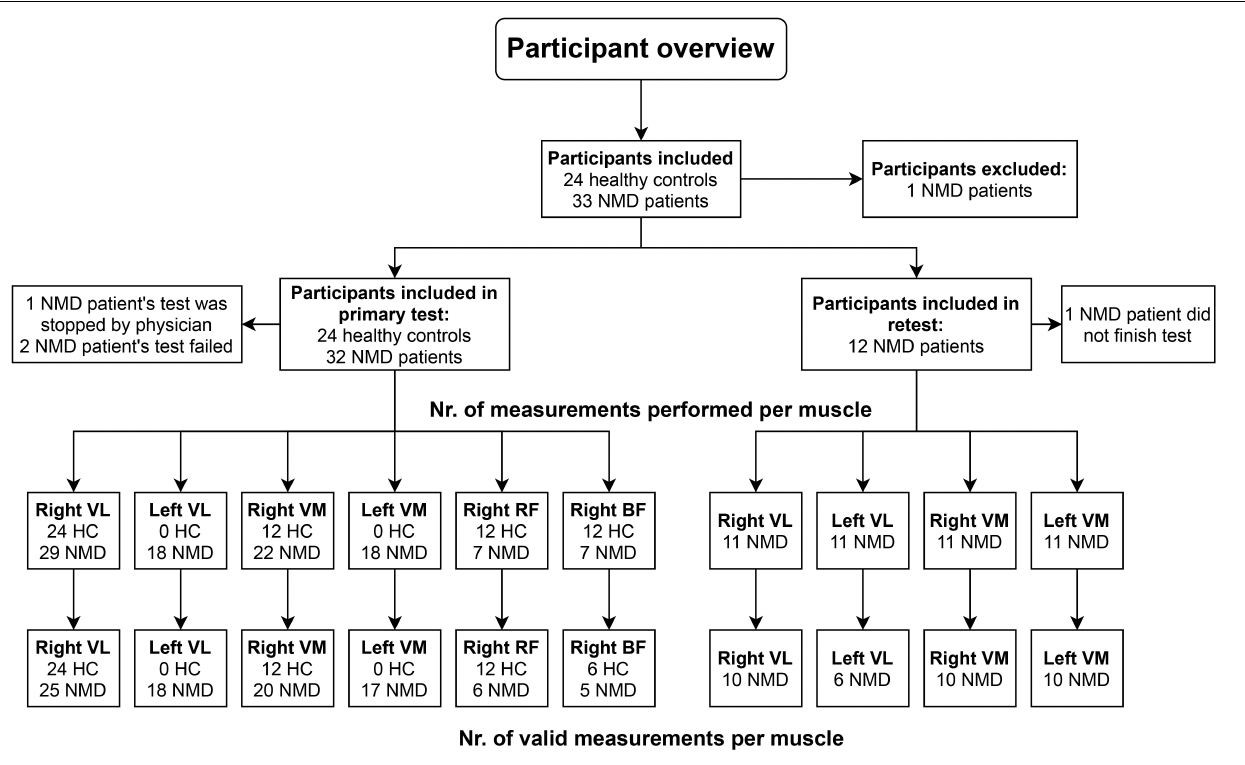
FIGURE 1 | Overview of measurements performed in the study. HC, healthy controls; NMD, patients with neuromuscular disorders; VL, vastus lateralis; VM, vastus medialis; RF, rectus femoris; BF, biceps